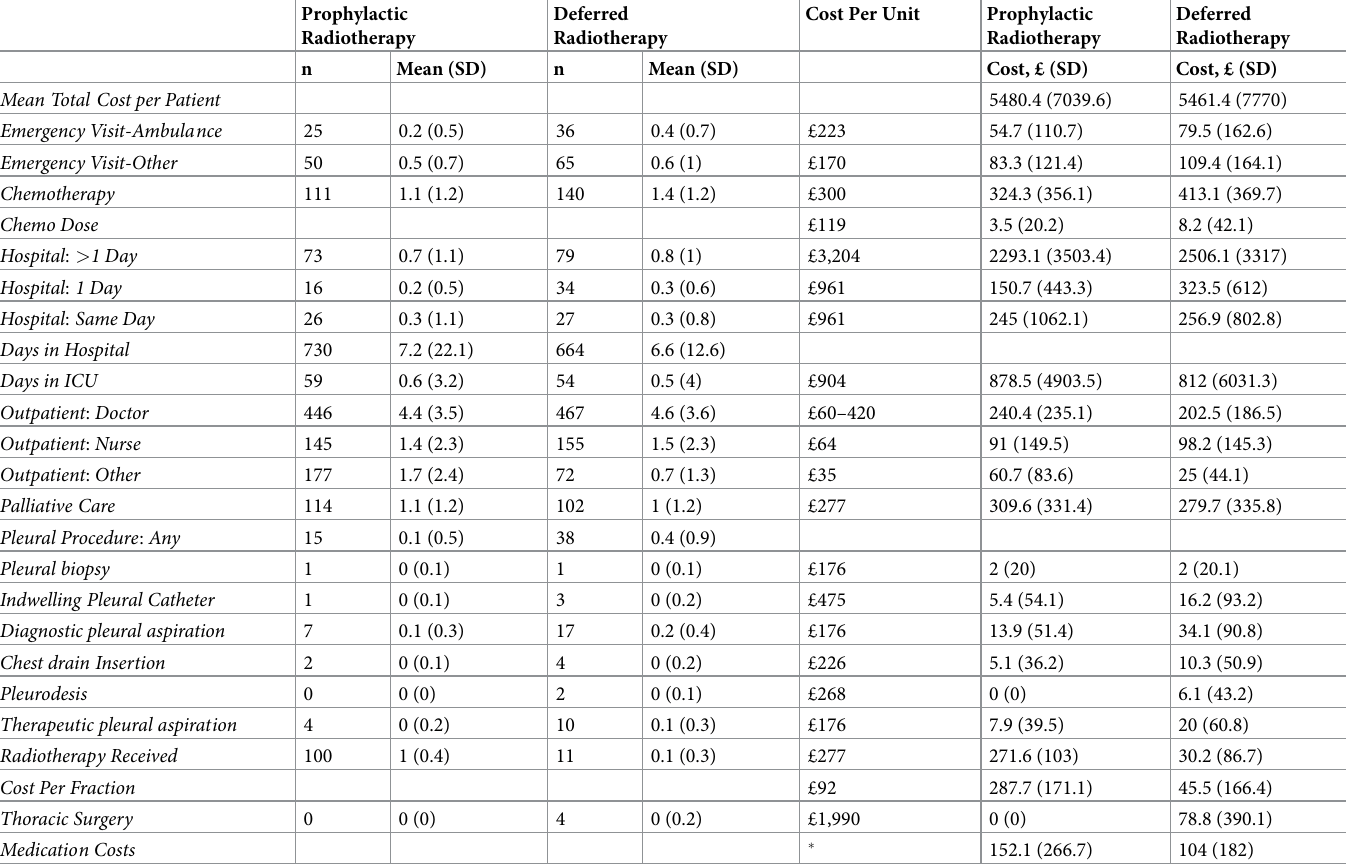
Table 1. Healthcare utilization and costs summary. See appendix A in S1 File for a detailed description of cost sources. Prophylactic